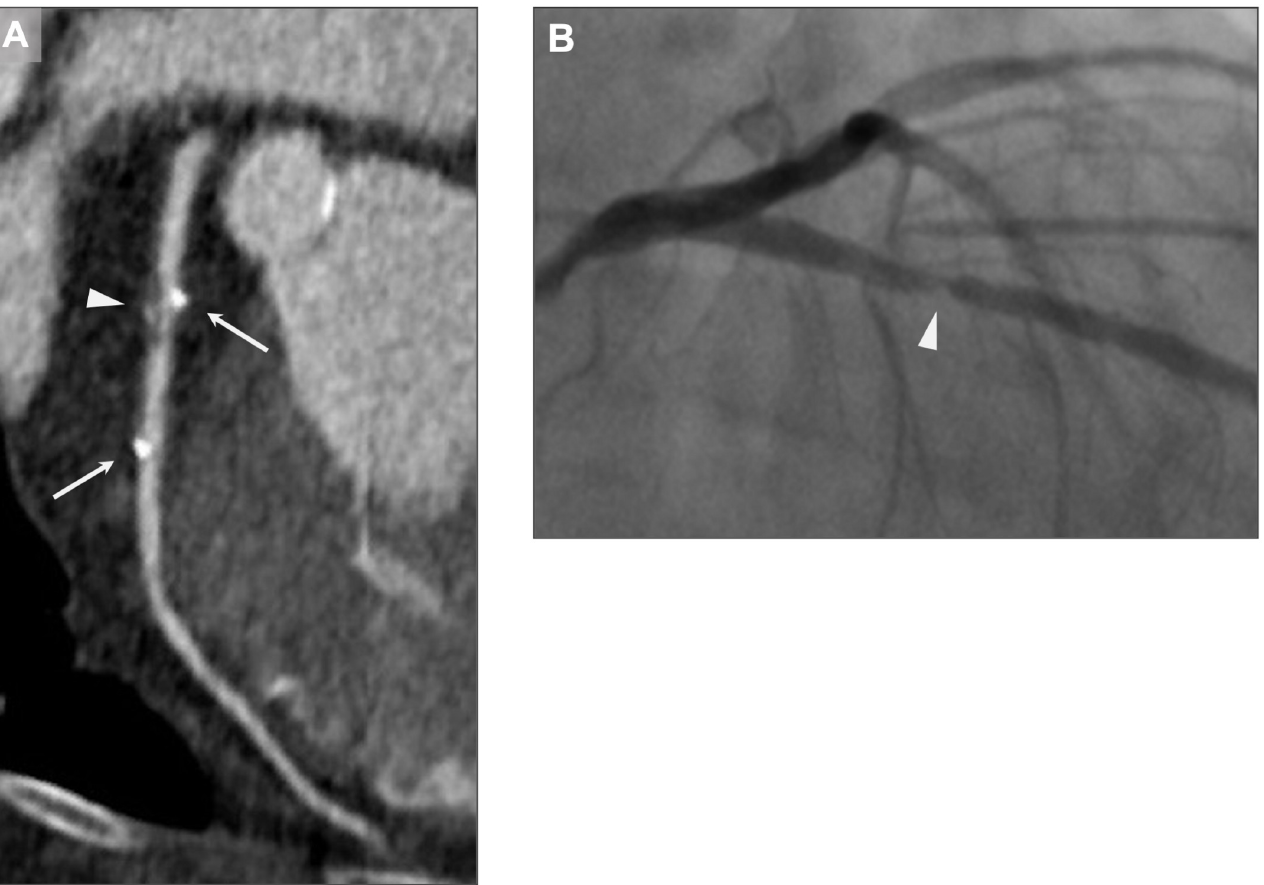
Fig 4. Intra-stent stenosis. A). ECG-gated 256-slice coronary CT angiography 14 months after BRS implantation, in a 61-yo woman. An edge and intra-stent mixed plaque with severe stenosis and positive remodeling is shown (arrowhead). Proximal and distal platinum indicators of the BRS (2.5 x 18 mm) are also visible (arrows). 2016 © ☯ Carl Chartrand-Lefebvre and Evguenia Zdanovich]. B) Conventional coronary angiography confirms severe intra-stent stenosis. The patient underwent stenting with an everolimus-eluting metallic stent in the same session. 2016 © ☯ Samer Mansour].